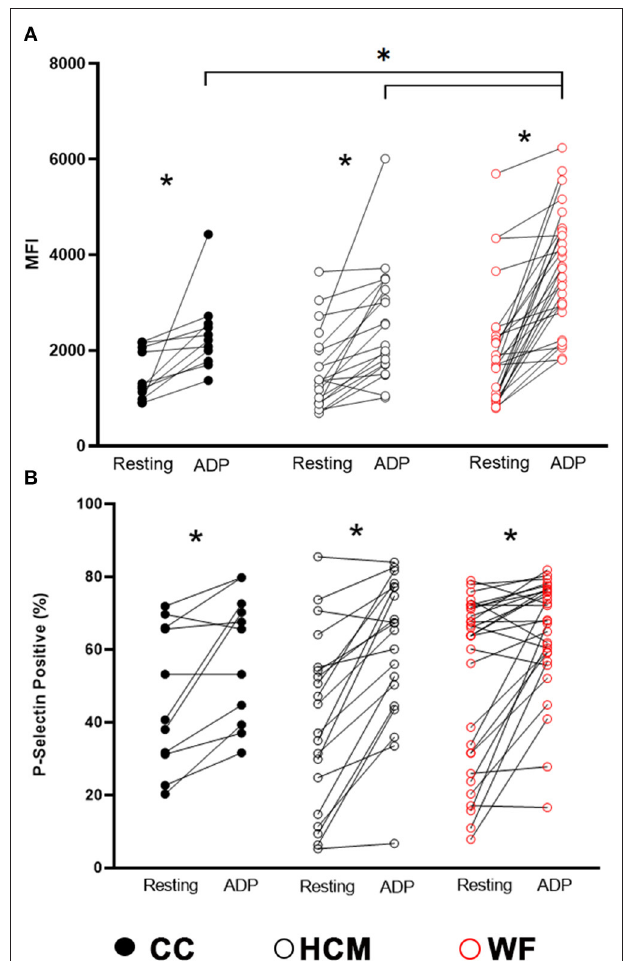
FIGURE 2 | Increased platelet priming led to augmented response to adenosine diphosphate in cats with naturally occurring wildfire injuries and smoke exposure. Platelet activation, measured as P-selectin median fluorescence intensity (MFI) (A) and percentage of P-selectin positive events (B) , was evaluated by flow cytometry in 29 cats exposed to wildfires (WF), 21 cats with subclinical hypertrophic cardiomyopathy (HCM) and 11 control cats without HCM (CC). Platelet rich plasma was activated with 20 µ M ADP and compared to unstimulated platelets (resting) within each group. ADP resulted in significant elevation in P-selectin expression in all 3 groups. WF cats had increased magnitude in P-selectin density (MFI) compared to cats in the HCM and CC groups in response to ADP. * p <